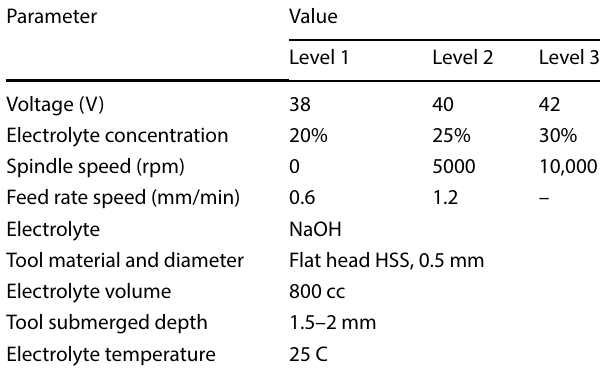
Table 1 Levels of input parameters of experimental